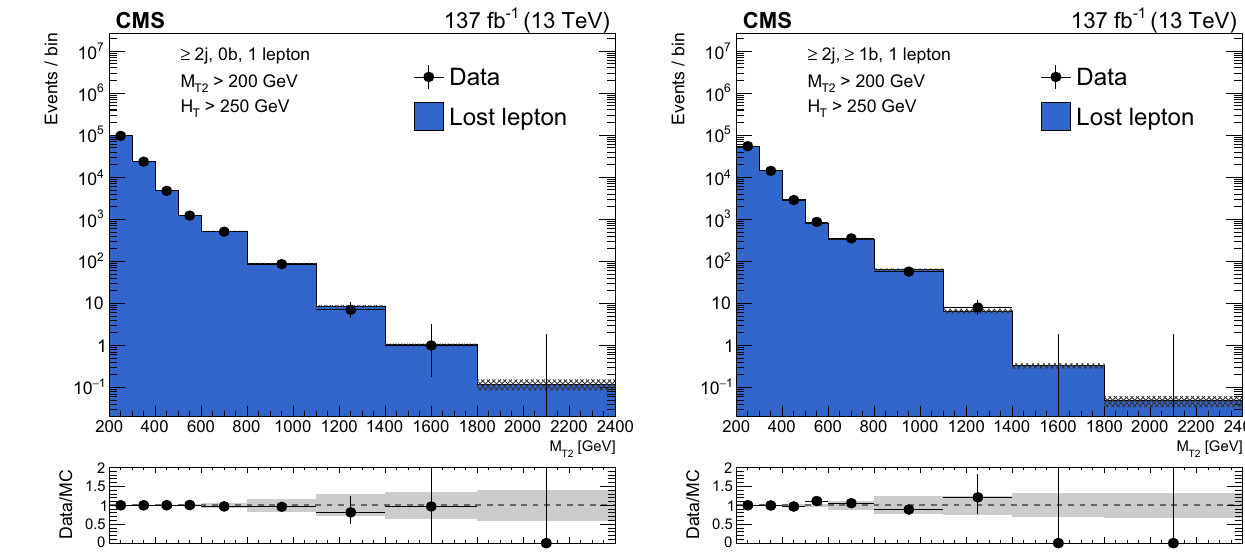
Fig. 1 Distributions of the M T2 variable in data and simulation for the single-lepton control region, after normalizing the simulation to data in binsof H T , N j ,and N b ,foreventswithnob-taggedjets(left),andevents with at least one b-tagged jet (right). The hatched bands on the top pan-